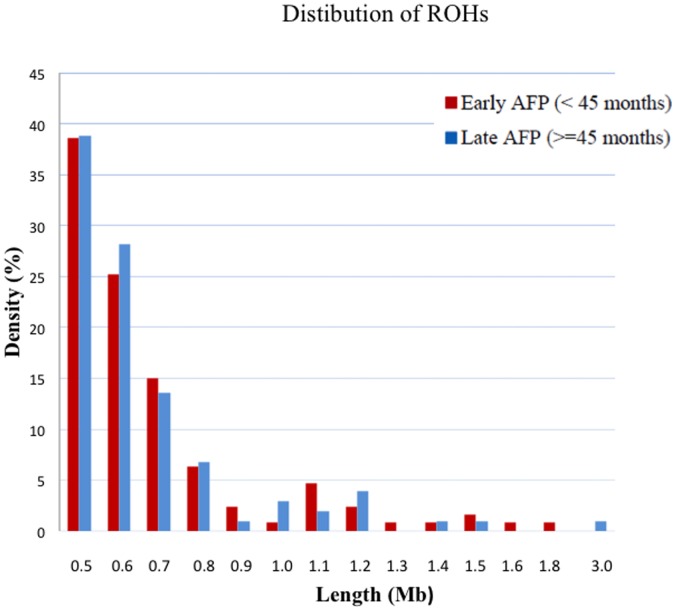
The distribution of runs of homozygosity (ROH) regions (by length of the ROH region) is shown.Age of first phrase (AFP) was classified into early-AFP and late-AFP groups by the k-means clustering algorithm.